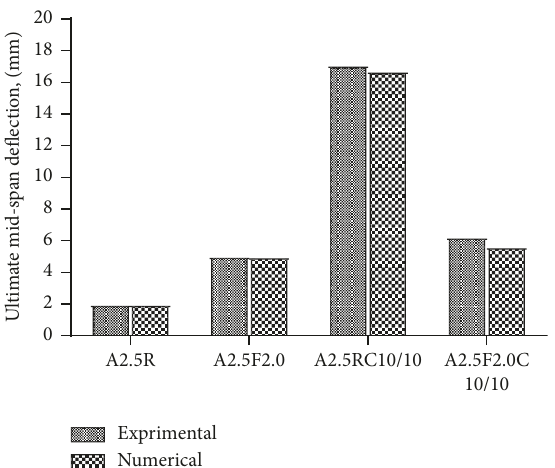
Figure 10: Comparison between ultimate experimental and ultimate numerical midspan deflection for all beams.